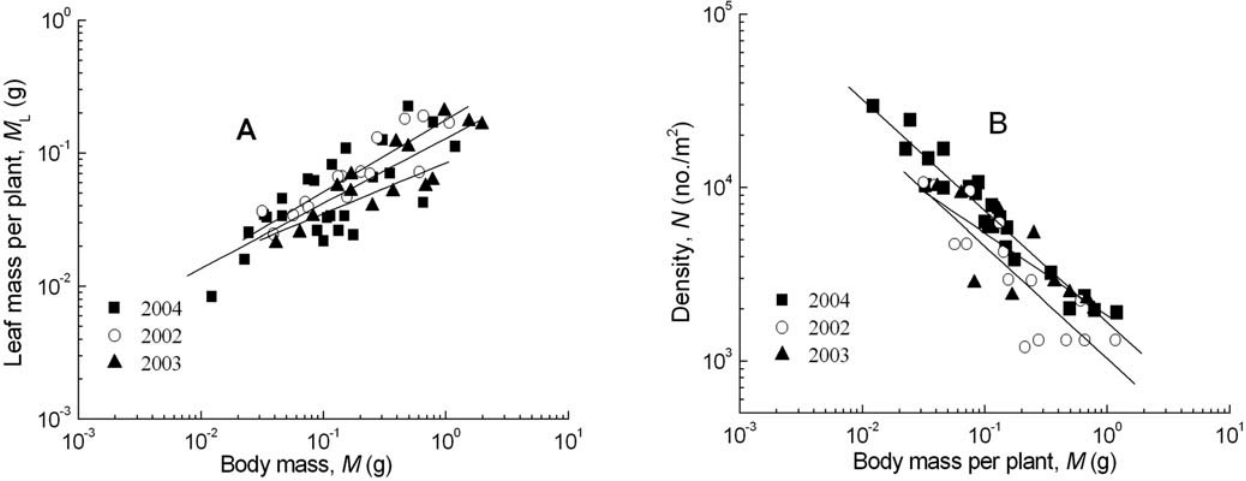
Figure 2. The allometric relationships between photosynthetic mass and body mass (A), and population density and body mass (B) for dense spring wheat populations. All regressions are significant at P , 0.0001 and the 95% CI of the slopes are statistically different from 3/4 and 2 3/4 (also see Table 1, 2), but the ratio of the two exponents is not statistically different from 2 1.